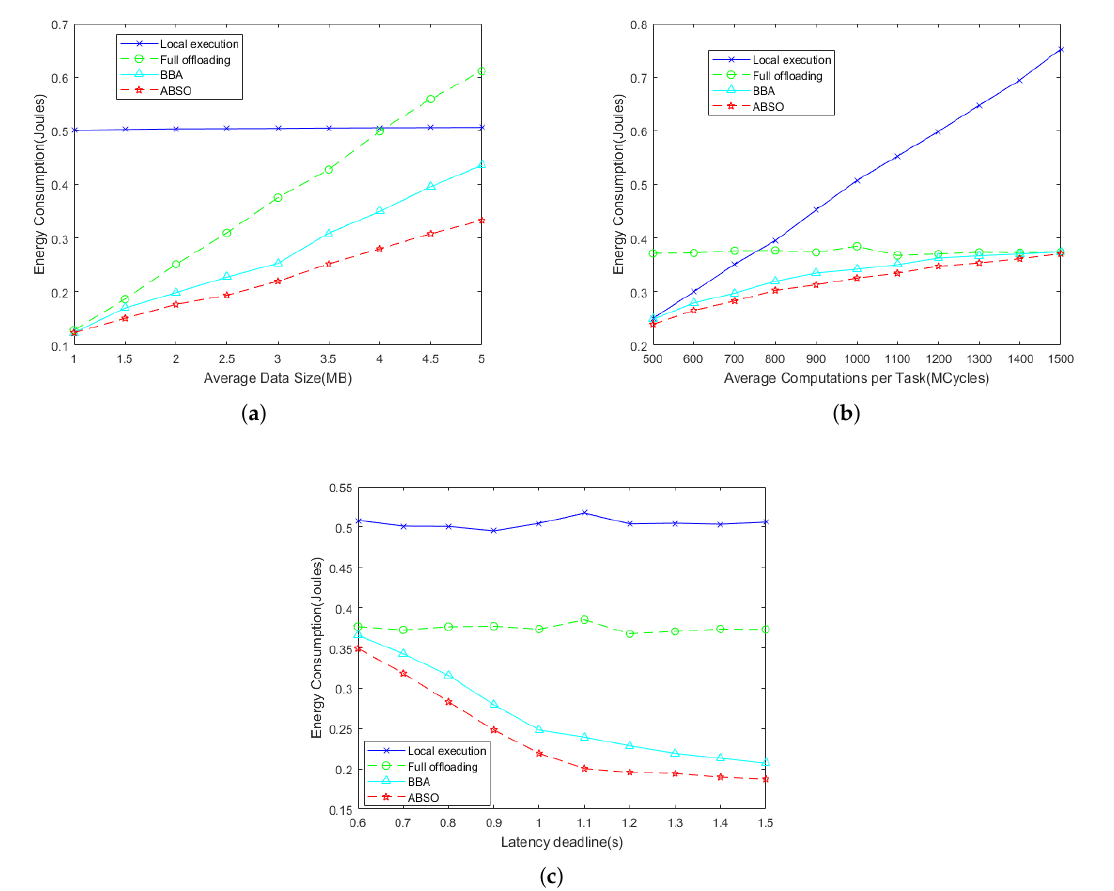
Figure 5. Comparison of energy consumption for different offloading strategies. ( a ) Effect of task size on energy consumption; ( b ) Effect of required computation cycles on energy consumption; ( c ) Effect of latency deadline on energy